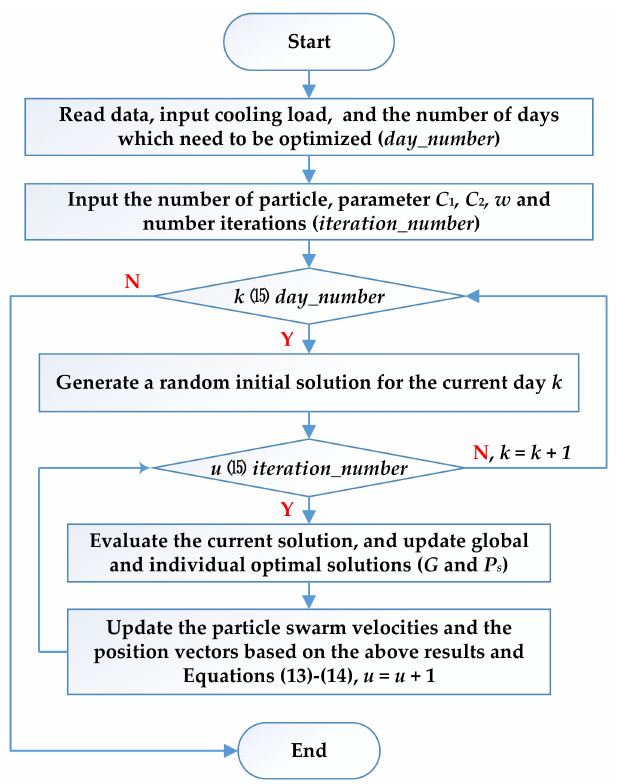
Figure 2. Flow chart of the algorithm for benchmark energy